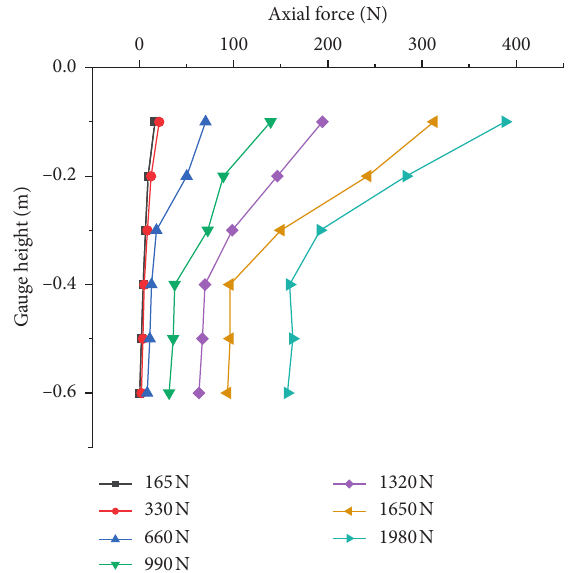
Figure 9: Variation curve of axial force of the inclined pile along pile height.